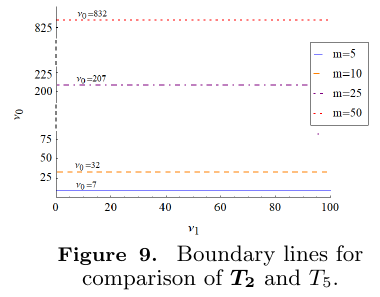
Figure 9. Boundary lines for comparison of T 2 and T 5 .